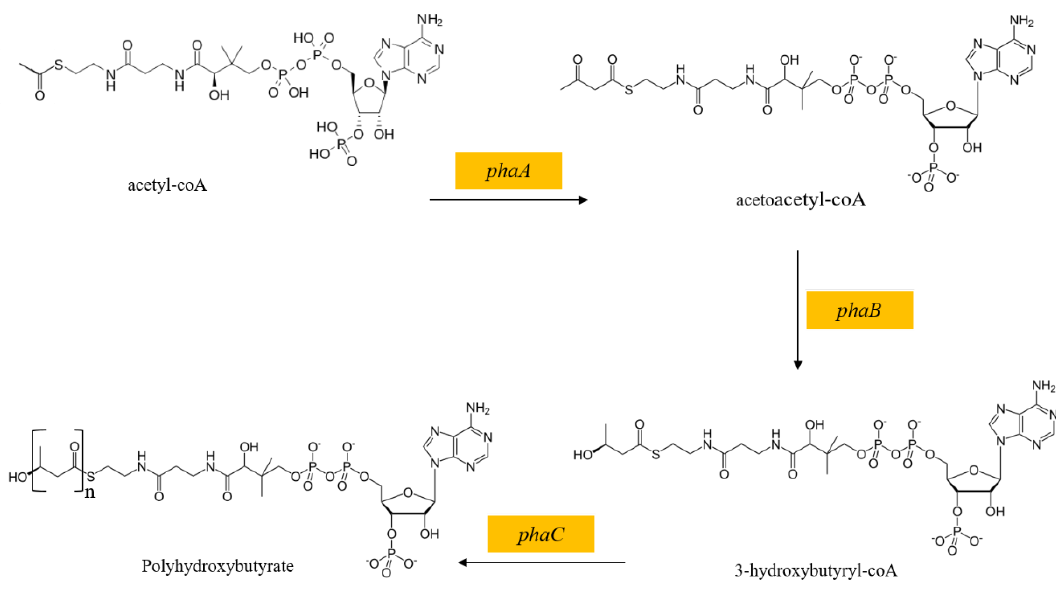
Figure 4. The PHB biosynthesis pathway.